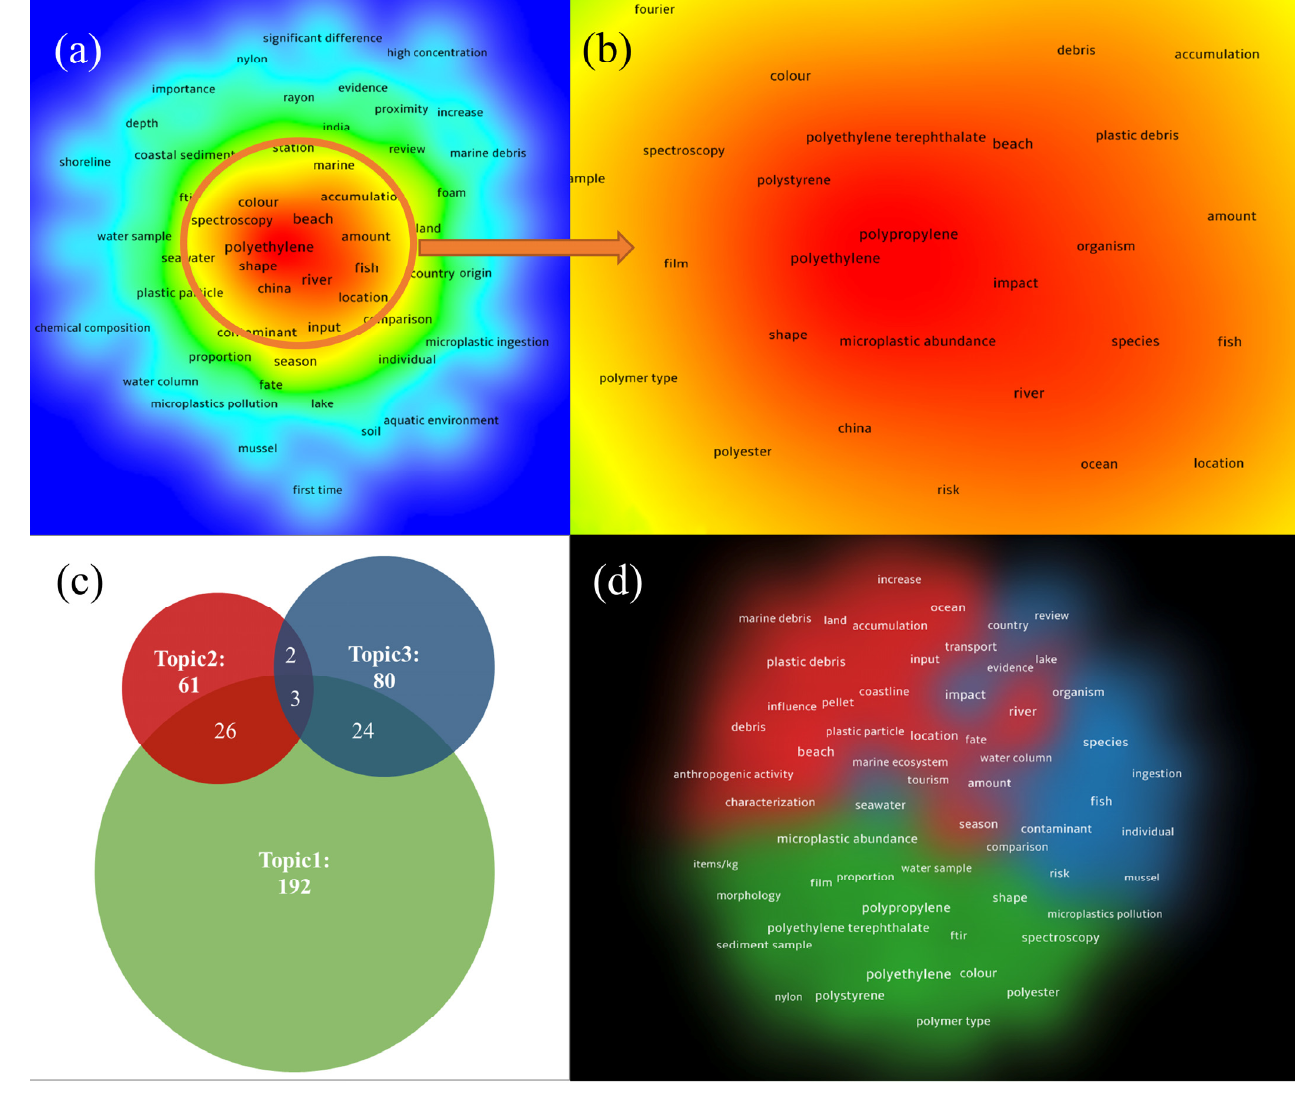
Figure 2. The item density and cluster density visualization map on microplastics in coastal agglom- eration researches based on occurrences from January 2009 to May 2022. ( a ) The item density view. ( b ) The magnification of the high-occurrence area in Figure 2a. ( c ) Venn diagram of the literature number of three clusters. ( d ) The cluster density view. In the item density view, gradient colors are shown by red-blue-green according to the term occurrence, the closer to the red area represents the higher occurrence of the term. In the cluster density view, different colors represent different clusters divided (the same color corresponding to the clustering class in Figure 2c).